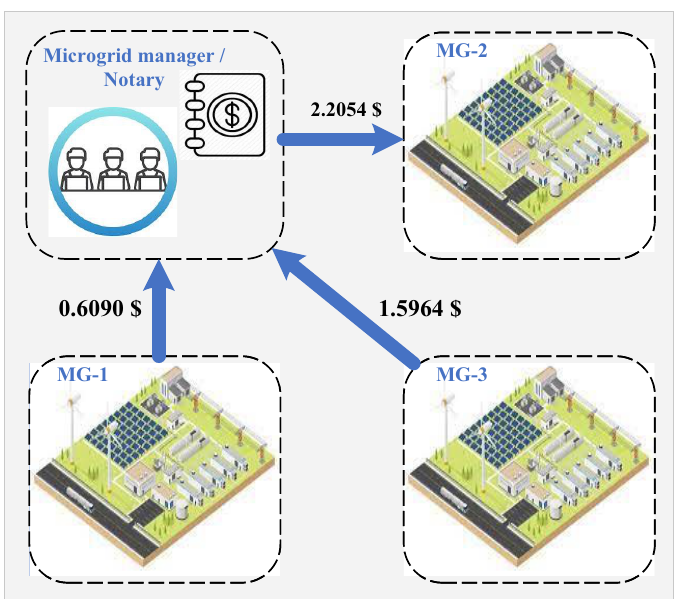
Figure 11. Local carbon market clearing